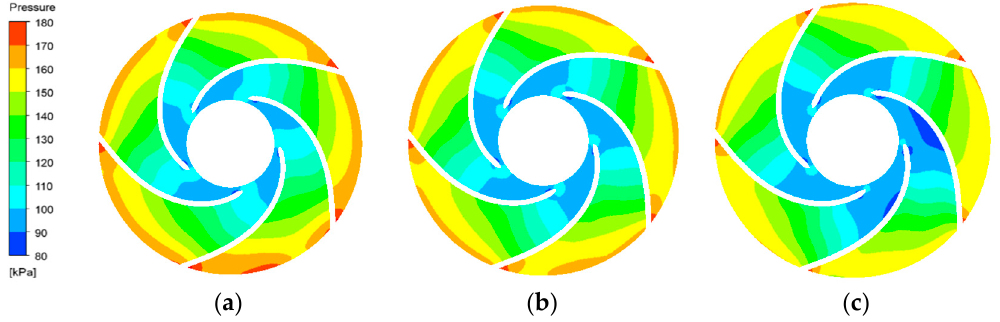
Figure 12. Comparison of pressure distribution in impeller for the two schemes: ( a ) origin , 0.8 Q d ; ( b ) origin, 1.0 Q d ; ( c ) origin , 1.25 Q d ; ( d ) optimization, 0.8 Q d ; ( e ) optimization, 1.0 Q d ; ( f ) optimization,